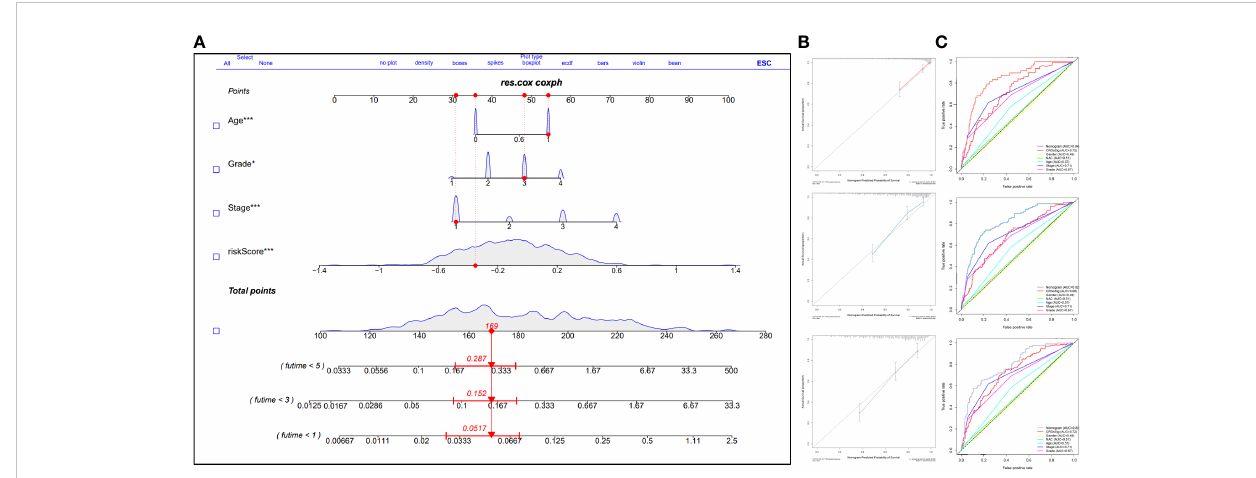
FIGURE 7 Construction and validation of the prognostic nomogram integrating prognostic signature and clinical parameters. (A) The nomogram based on the signi fi cant clinical parameters and risk signature. (B) Calibration curves of the nomogram for 1-, 3-, and 5-year survival prediction. (C) The AUC value of ROC cruves of the nomogram, risk signature, and clinical parameters. GP style: *: p< 0.05;